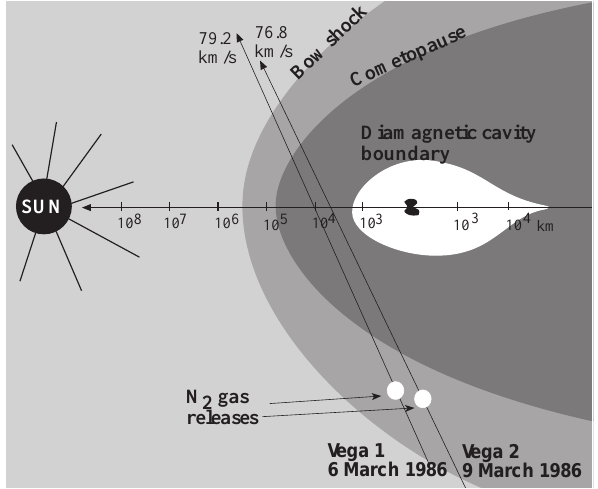
Fig. 2. Locations of the N 2 gas releases along the Vega 1 and Vega 2 trajectories during their comet Halley approaches.